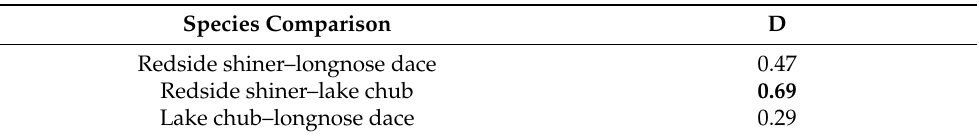
Table 2. Schoener’s index of dietary overlap (D) for redside shiner, longnose dace, and lake chub collected in the littoral zone of Yellowstone Lake during the ice-free season of 2020. Bold values indicate a high degree of dietary overlap (>0.60